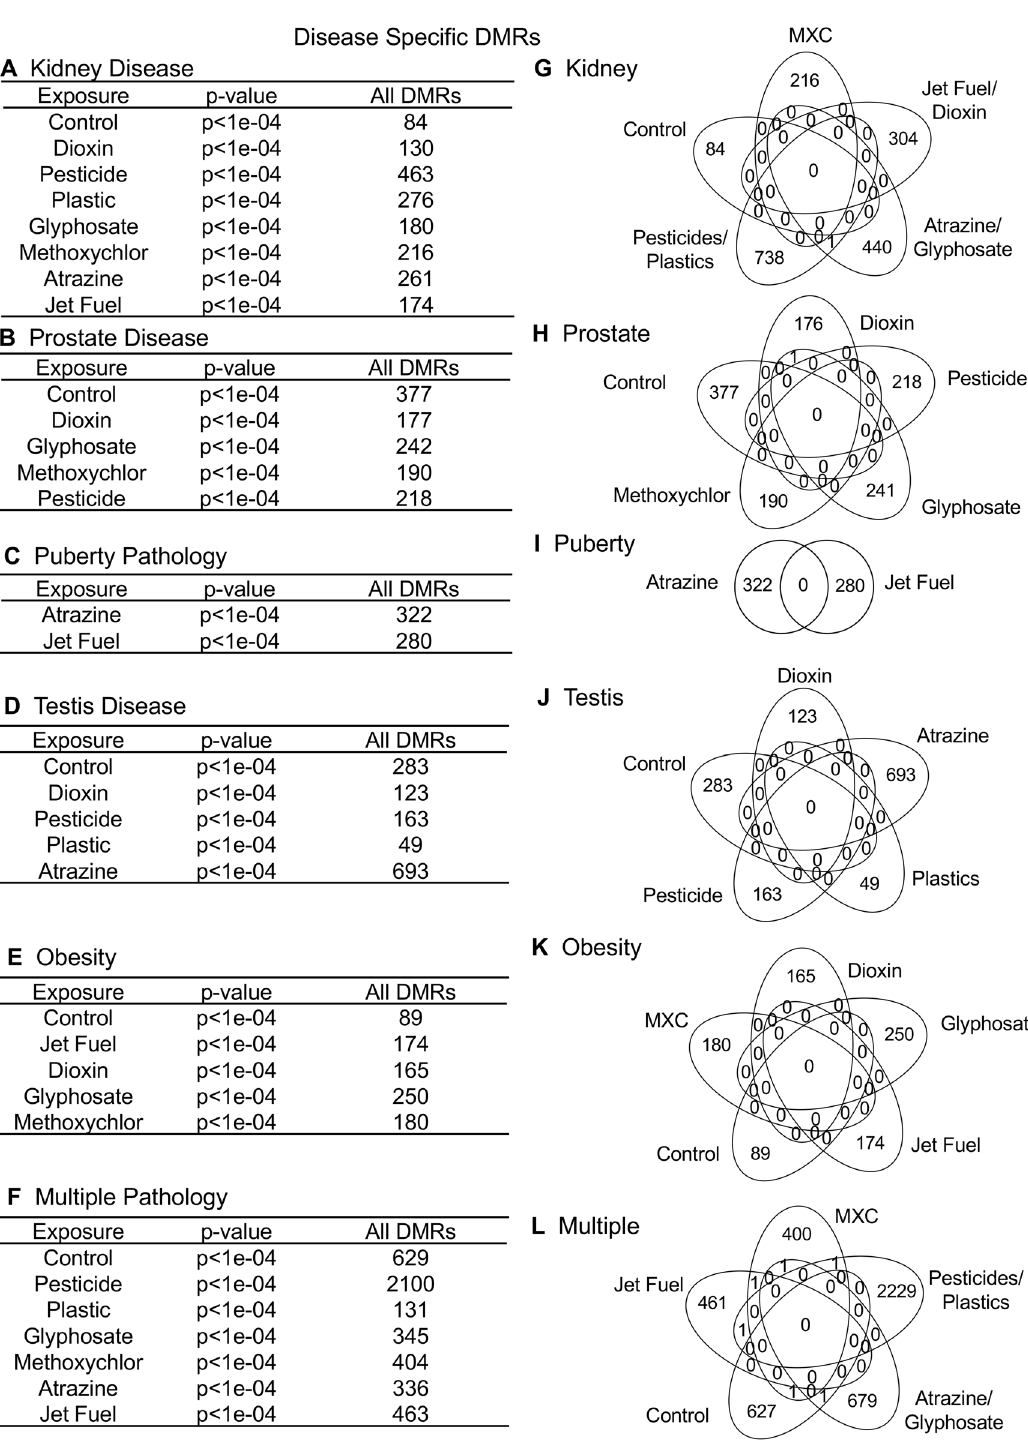
Figure 2. Specific disease DMRs. ( A ) Kidney disease; ( B ) Prostate disease; ( C ) Puberty pathology; ( D ) Testis disease; ( E ) Obesity; ( F ) Multiple pathology. The exposure, p value and number of DMR are presented. Venn diagram overlaps for each exposure DMR set are shown for ( G ) Kidney; ( H ) Prostate; ( I ) Puberty; ( J ) Testis; ( K ) Obesity; ( L )